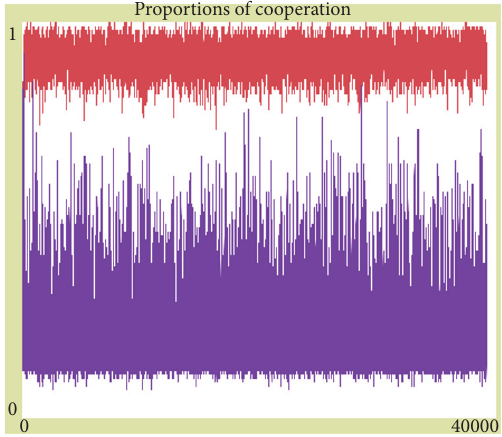
Figure 7: Simulation on knowledge workers’ CWB when working environment is poor.